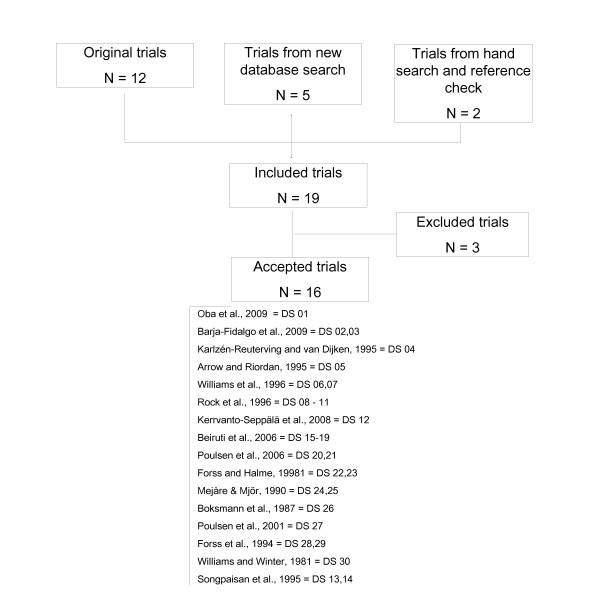
Flow diagram of trial selection. N = Number of trials; DS = Dataset number.